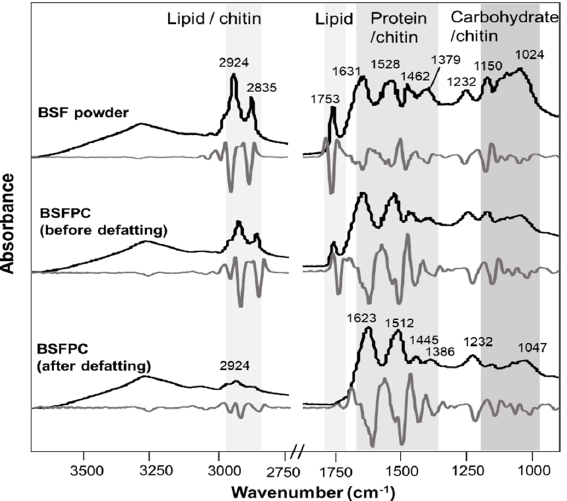
Figure 2. Attenuated total reflectance Fourier transform mid infrared spectroscopy (FTIR) raw spectra (black line) of BSF (black soldier fly) powder and BSFPC (black soldier fly protein concentrate) before and after defatting and the corresponding Savitzky–Golay’s second derivatives (grey line).